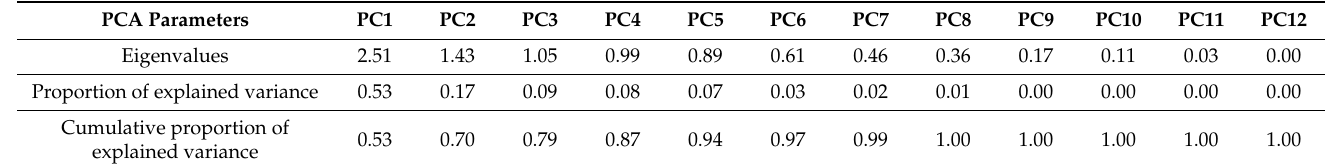
Table 5. Importance of components determined by Principal Component Analysis.